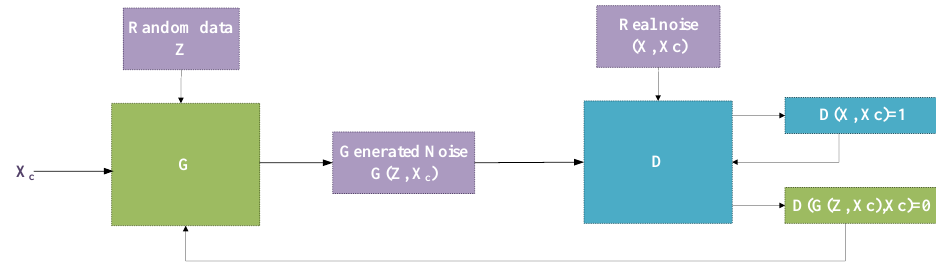
Figure 2. Noise generation process.